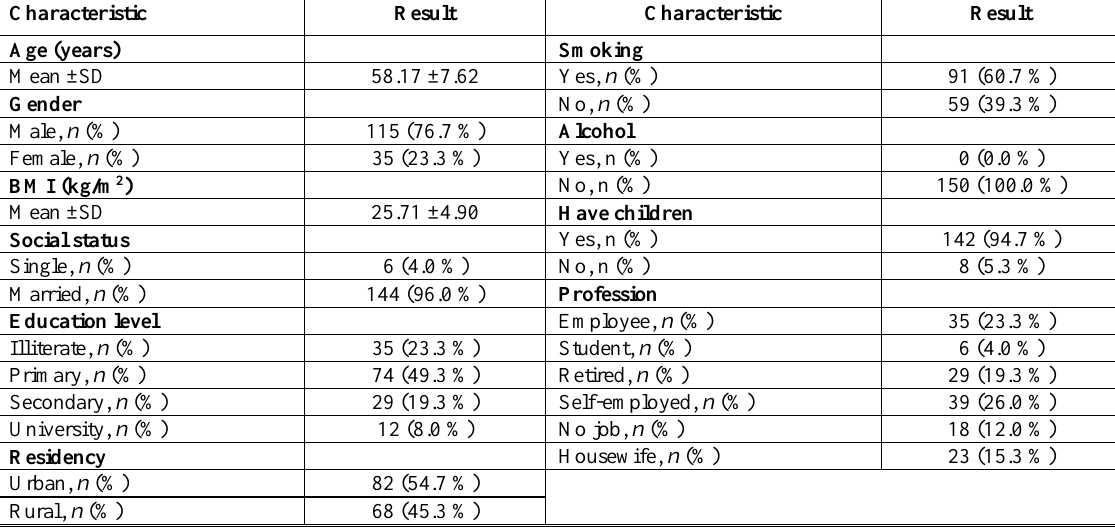
Table 1. Sociodemographic characteristics of COPD patients enrolled in the current study Characteristic Result